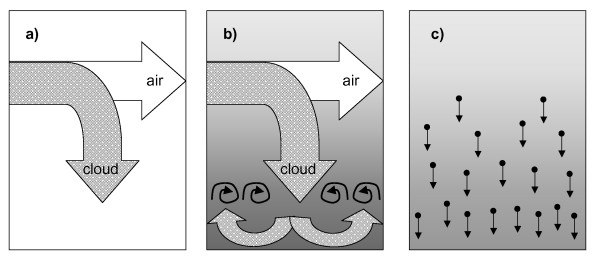
Principle of operation of the air-liquid interface cell exposure system (ALICE). Three phases can be distinguished: During phase 1, a dense cloud embedded in an air flow is introduced into the empty chamber (panel a). During phase 2, the continuously supplied cloud forms a vortex near the bottom of the chamber and fills the chamber from bottom to top, while depleted air is extracted from the top part of the chamber (panel b). During phase 3, the flow and hence the influx of the cloud is stopped and the cloud -filled chamber is gradually depleted due to single particle settling (panel c).